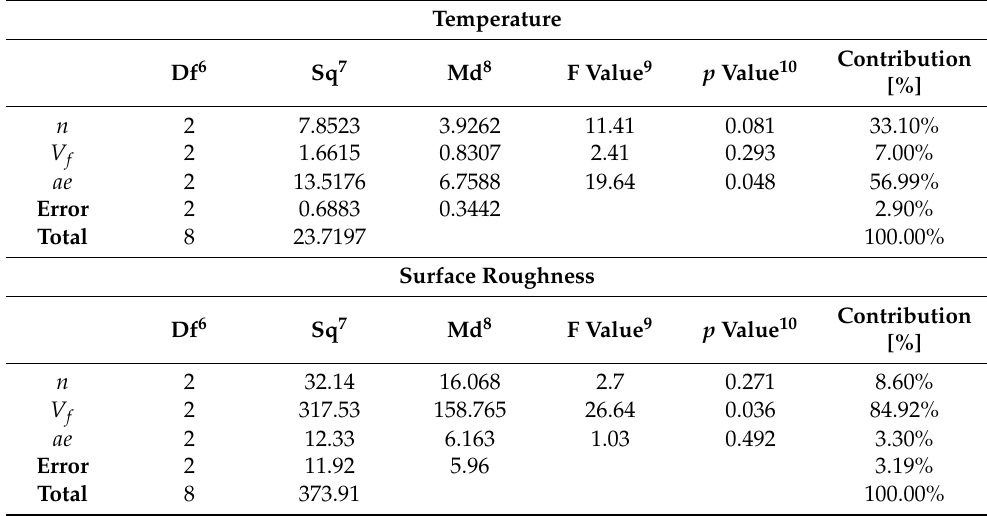
Table 11. ANOVA analysis of chip temperatures and surface roughness of the workpiece after machining tests without lubrification